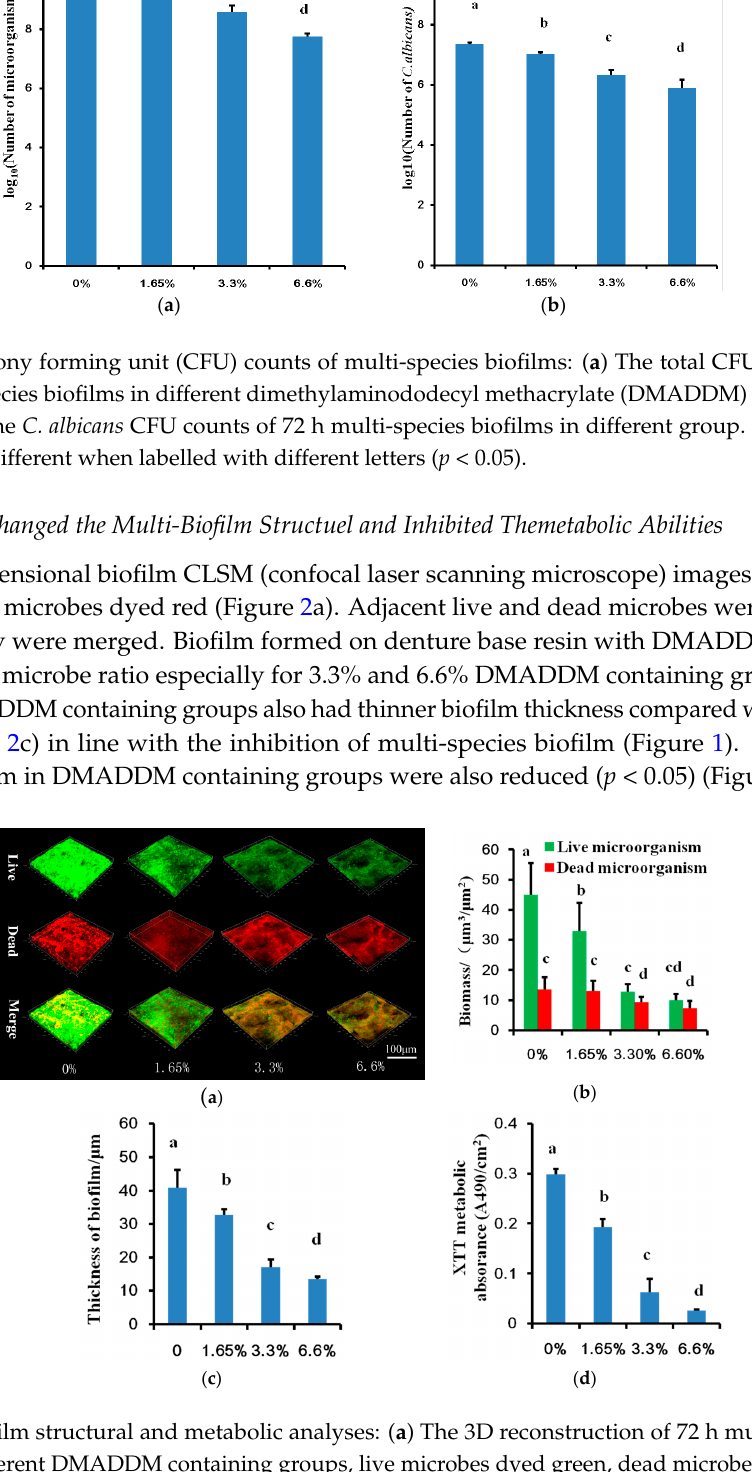
Figure 2. Biofilm structural and metabolic analyses: ( a ) The 3D reconstruction of 72 h multi-species biofilm in different DMADDM containing groups, live microbes dyed green, dead microbes dyed red, adjacent live and dead microbes were presented as yellow when they were merged; ( b ) The biomass of 72 h multi-species biofilm; ( c ) The thickness of 72 h multi-species biofilms in different DMADDM containing groups; ( d ) The 2,3-bis(2-methoxy-4-nitro-5-sulfophenyl)-2H-tetrazolium-5-carboxanilide (XTT) results of multi-species biofilms formed on different DMADDM containing denture base resin. Values are significantly different when labelled with different letters ( p < 0.05).